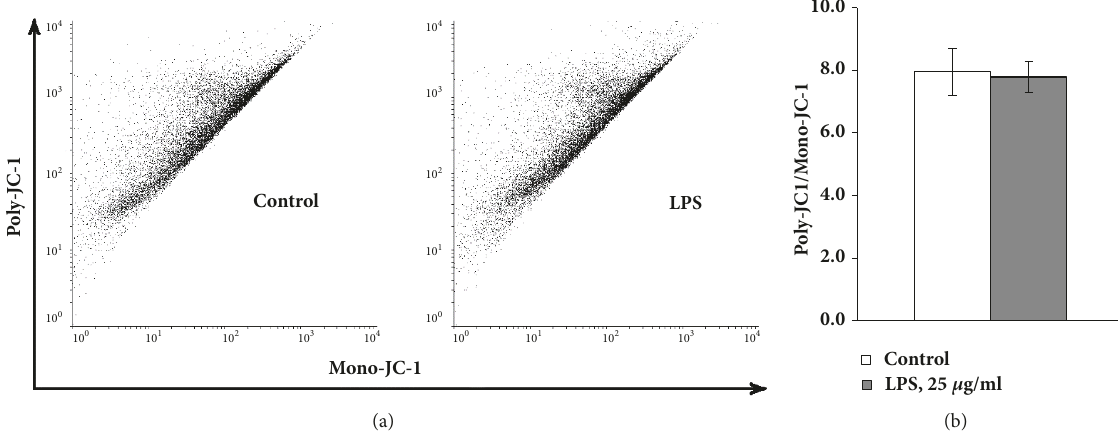
Figure 4: LPS does not change MPP in FUBEC. Cells were incubatedwith 25 𝜇 g/ml LPS for 21 h followed by staining with JC-1 and red/green imagedensity measurements.The green fluorescencedensity indicated JC-1monomerswhile the red fluorescencedensity JC-1-polymers.n=4 independent experiments.